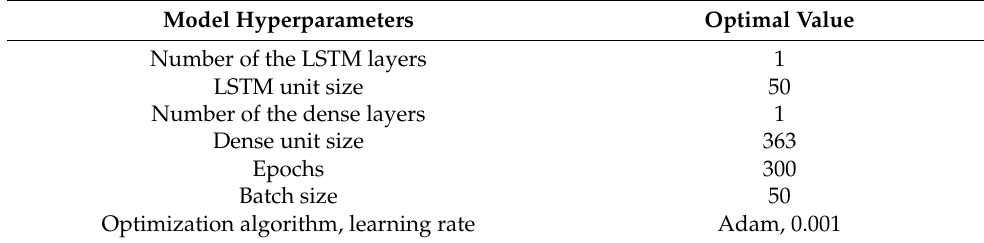
Table 4. Proposed architecture for the optimal LSTM model.